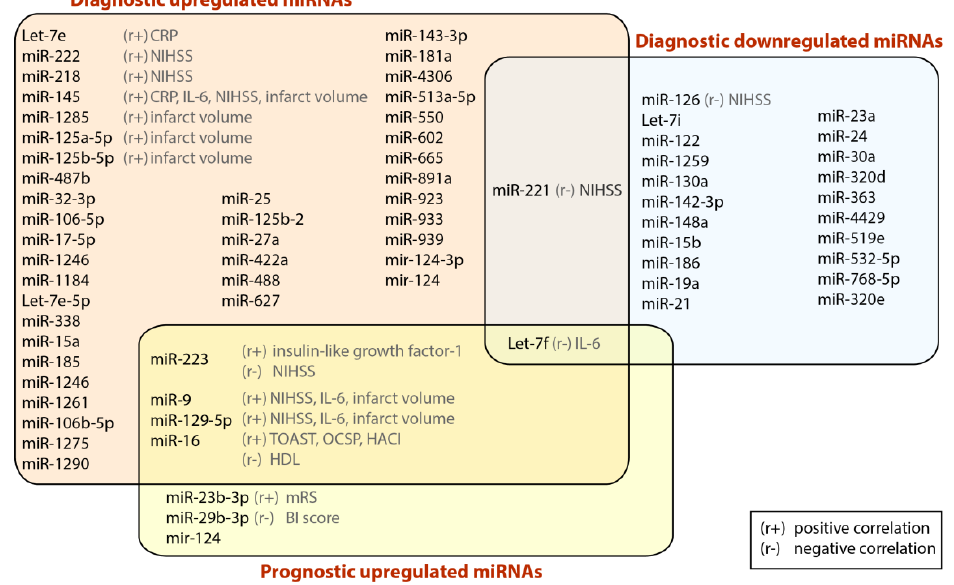
Figure 1. Regulation of diagnostic and prognostic miRNAs serving as biomarkers in ischemic stroke, based on human studies. Abbreviation: miRNA, microRNA; CRP, C-reactive protein; HDL, high density lipoprotein; NIHSS, National Institutes of Health Stroke Scale; IL-6, interleukin 6; TOAST, Trial of Org 10,172 in Acute Stroke Treatment; OCSP, Oxfordshire Community Stroke Project; HACI, hyperacute cerebral infarction; mRS, Modified Rankin Scale; BI, Barthel index. Refs: [41,43 – 45,47,48,53,55,57,58,61,62,67,68,72 – 76,78].